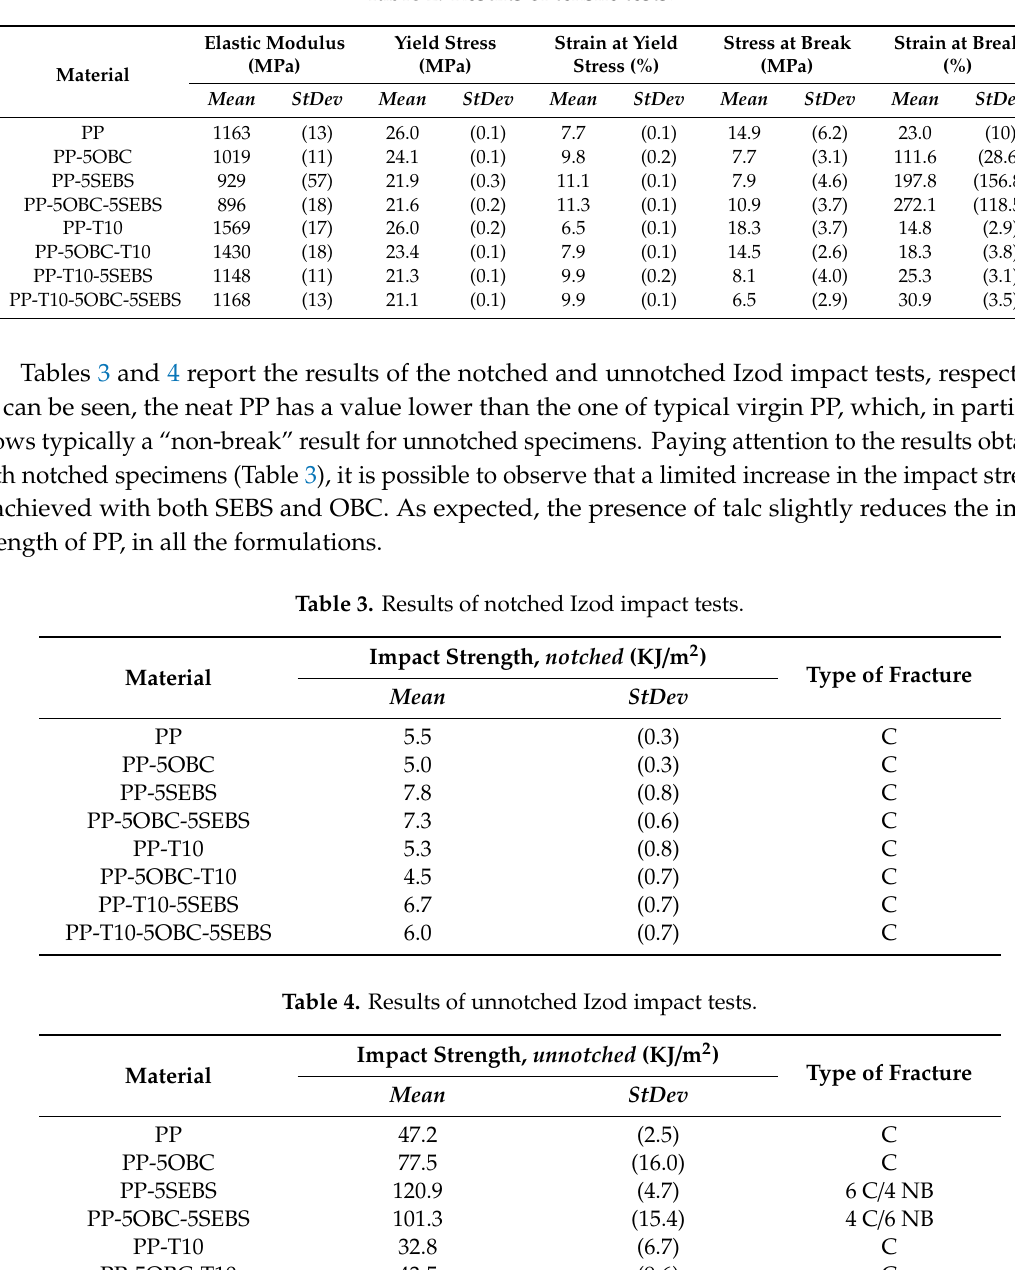
Table 2. Results of tensile tests.